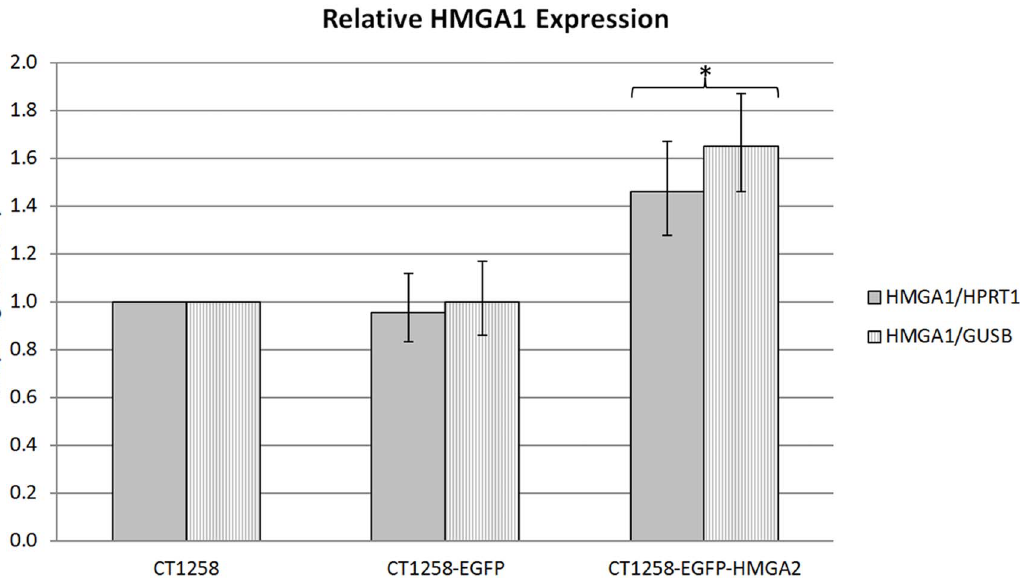
Figure 5. HMGA1 real-time PCR analyses. Relative HMGA1/HPRT1 and HMGA1/GUSB expression in native CT1258, CT1258-EGFP and CT1258- HMGA2-EGFP cells. Error bars are standard deviations. *p # 0.05 indicates a statistical significant increased expression of HMGA1 in CT1258-HMGA2- EGFP cells when compared to native CT1258 and CT1258-EGFP. doi:10.1371/journal.pone.0098788.g005 cell line (p= 0.016). In CT1258-EGFP-HMGA2 the SNAI1